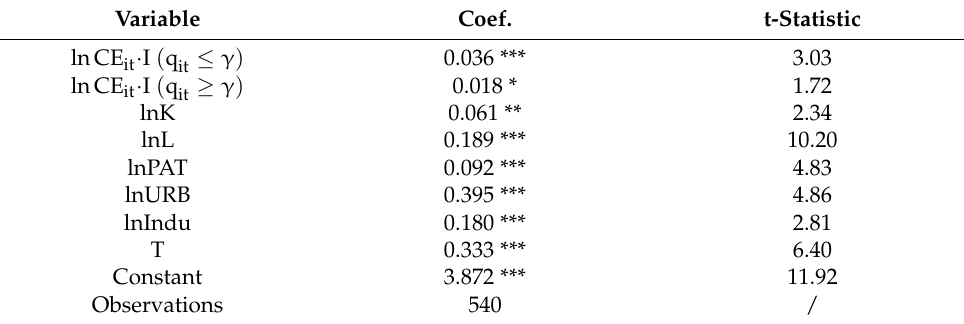
Table 5. Regression results of 27 provinces after excluding special samples. Variable Coef. t-Statistic ≤ γ ) 0.036 *** lnCE it · I ( q it